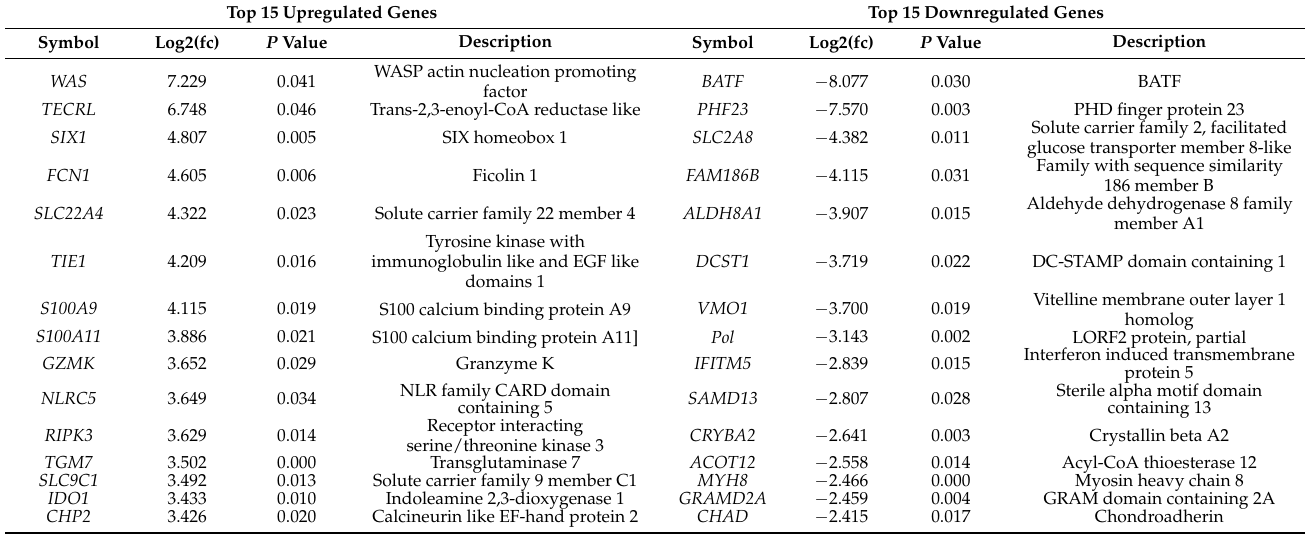
Table 3. Top 15 upregulated and downregulated genes in FDM retina compared to naïve control retina. Top 15 Upregulated Genes Top 15 Downregulated Genes Symbol P Value